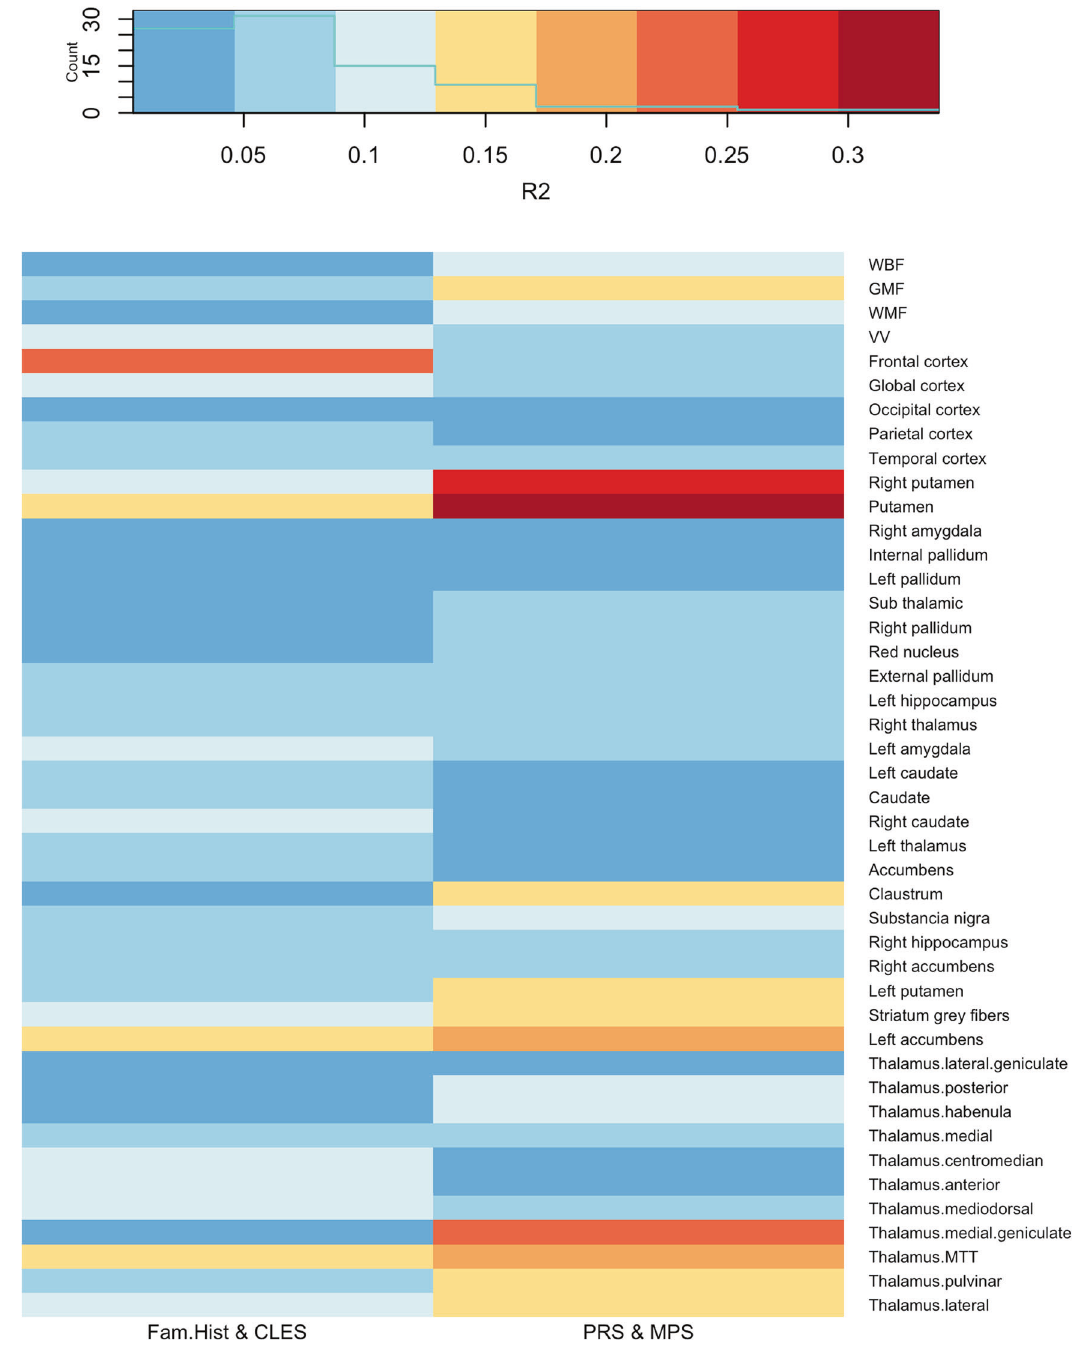
Fig. 1 Partial R 2 statistics for the interaction models relating clinical or molecular gene – environmental factors (i.e., family history and CLES or PRS and MPS) to brain structure